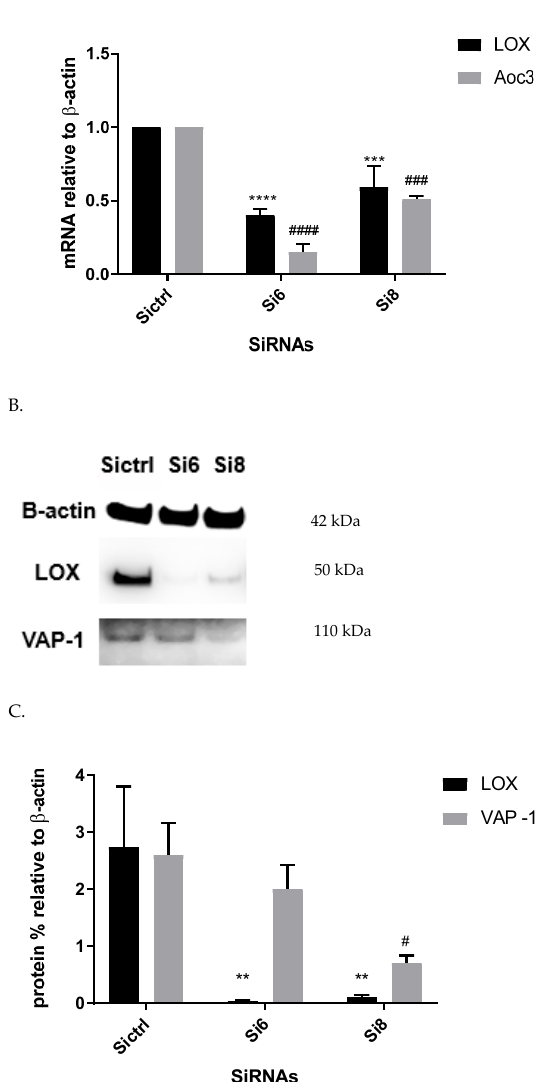
Figure 6. LOX (black bars) and Aoc3 (grey bars) gene expression (expressed as fold-change compared with control after normalization to the housekeeping gene β -actin) in early passage (2 and 3) VSMCs cells treated with Si control, SiRNA6, and SiRNA8 ( A ). For LOX, **** p < 0.0001 for Si6 vs. Sictrl and *** p < 0.001 for Si8 vs. Sictrl. For Aoc3, #### p < 0.0001 for Si6 vs. Sictrl and ### p < 0.001 for Si8 vs. Sictrl. LOX and VAP-1 protein expression in rat aortic VSMCs 72 h post transfection with Si control (Sictrl), SiRNA6 (Si6), and SiRNA8 (Si8) ( B ). LOX (black bars) and VAP-1 (grey bars) protein expression (expressed as percentage relative to β -actin) in early passage (2 and 3) VSMCs cells treated with Si control, SiRNA6, and SiRNA8 ( C ). For LOX, ** p < 0.01 for Si6 and Si8 vs. Sictrl. For VAP-1, # p < 0.05 for Si8 vs. Sictrl. Values are mean ± S.E.M. (n =